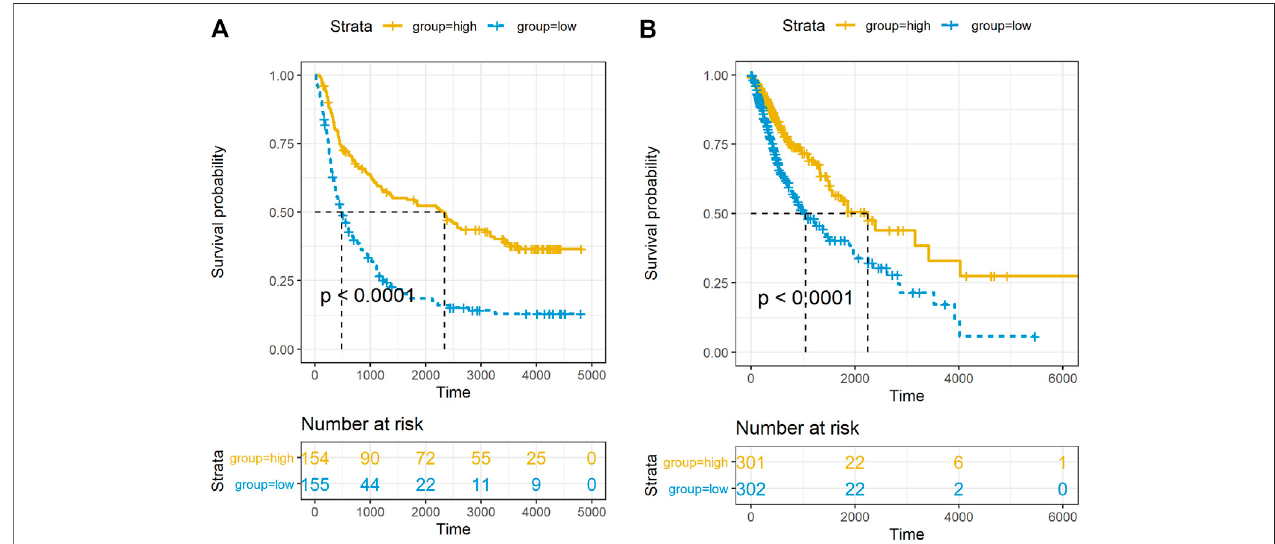
FIGURE 5 | Relationship between PACSIN1 expression and survival status and time. Kaplan-Meier estimates of survival for all grades in the CGGA (A) and TCGA datasets (B) .